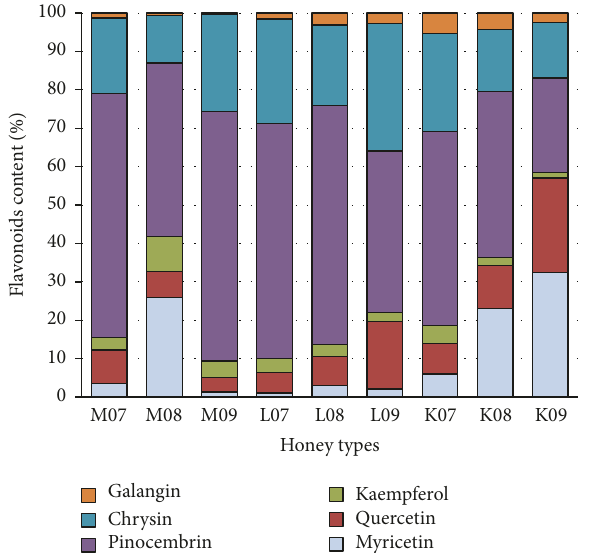
Figure 2: The chemical profiling of flavonoids in polyfloral honeys from northern Belgium. M07–M09 (honey samples from Mortsel apiary), L07–L09 (honey samples from Lichtaart apiary), and K07–K09 (honey samples from Kasterlee apiary).